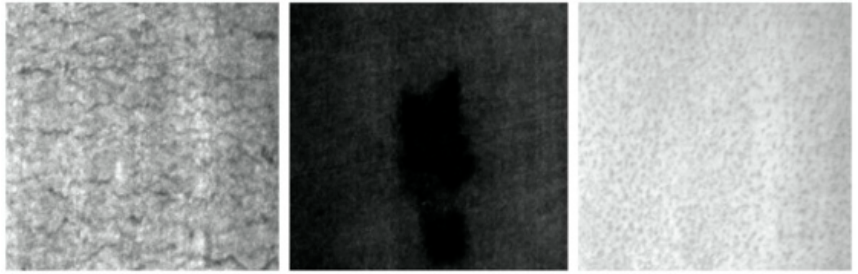
Figure 7. Defect images of crazing, patches, and pitted surface.